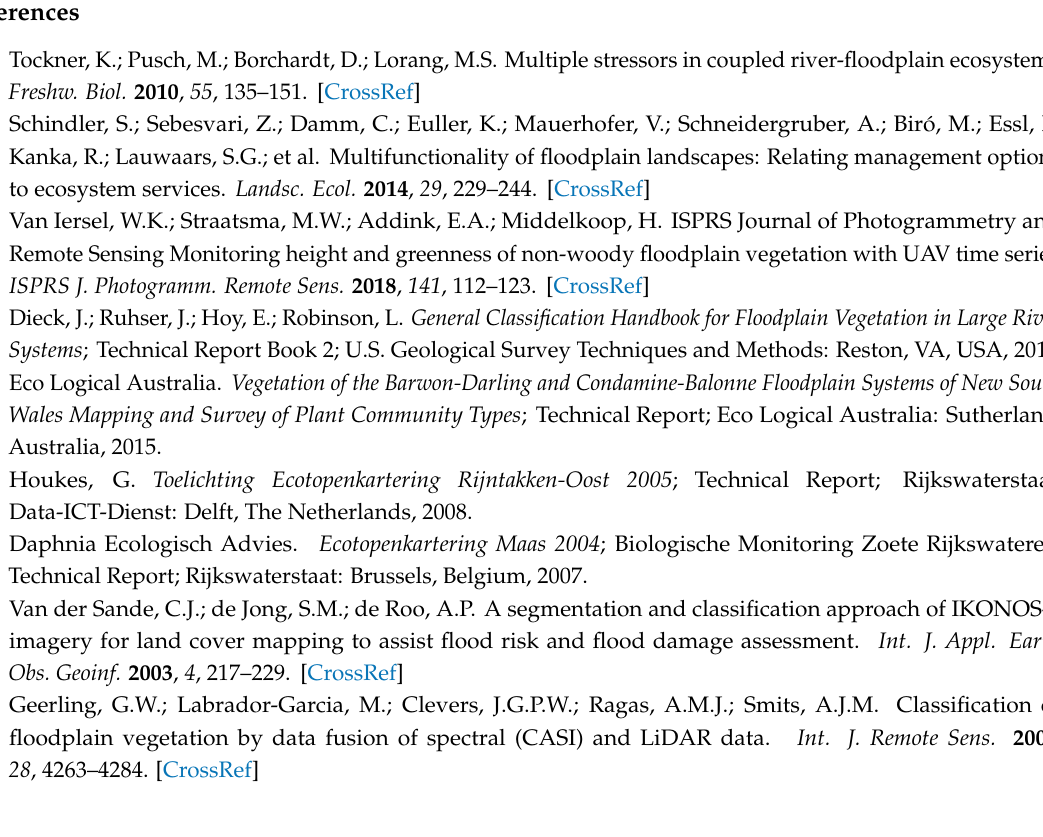
Figure S1. The nine field plots containing a mixture of two vegetation types, Figure S2. Field impressions of the vegetation types in the Breemwaard study area, Figure S3. Accuracy of the RF classification by decreasing number of time steps for different sampling of the training and validation sets from the reference data, Table S1. Error matrices of classifications with 1) RF maxn = 25 and RF default with structural and spectral data and RF maxn = 25 with only spectral data for segmentations with six ( n = 6) and one ( n = 1) time steps, Table S2: Classification accuracy with step-wise decrease in number of time steps with reversed training and validation set in the RandomForest classification, Table S3: Classification accuracy with step-wise decrease in number of time steps with random sampling of training and validation set per